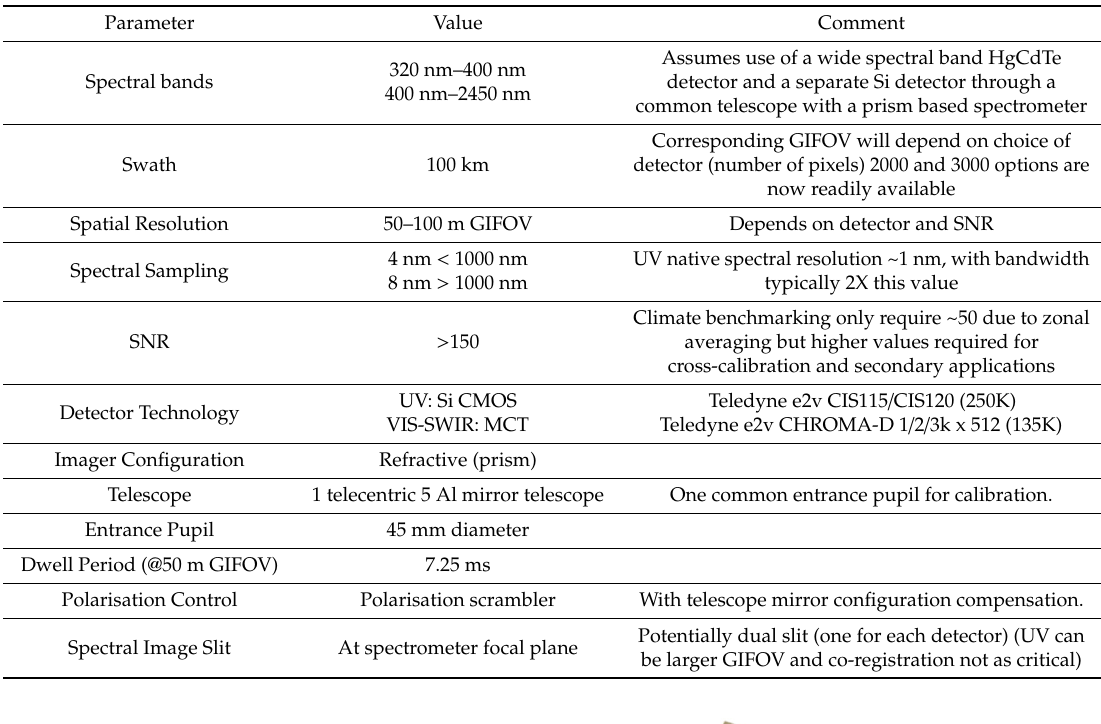
Table 8. Indicative hyperspectral imaging spectrometer (HIS) specifications based on an indicative implementation.